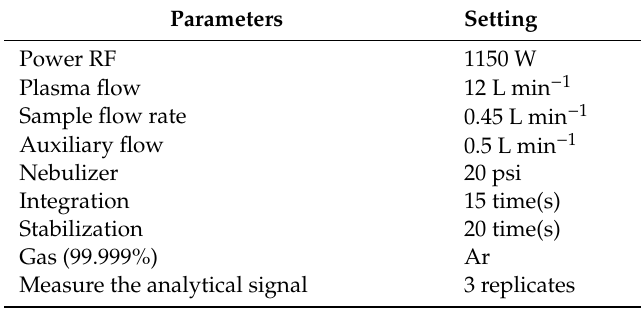
Table 8. Instrumental parameters for elemental determinations using axially viewed ICP